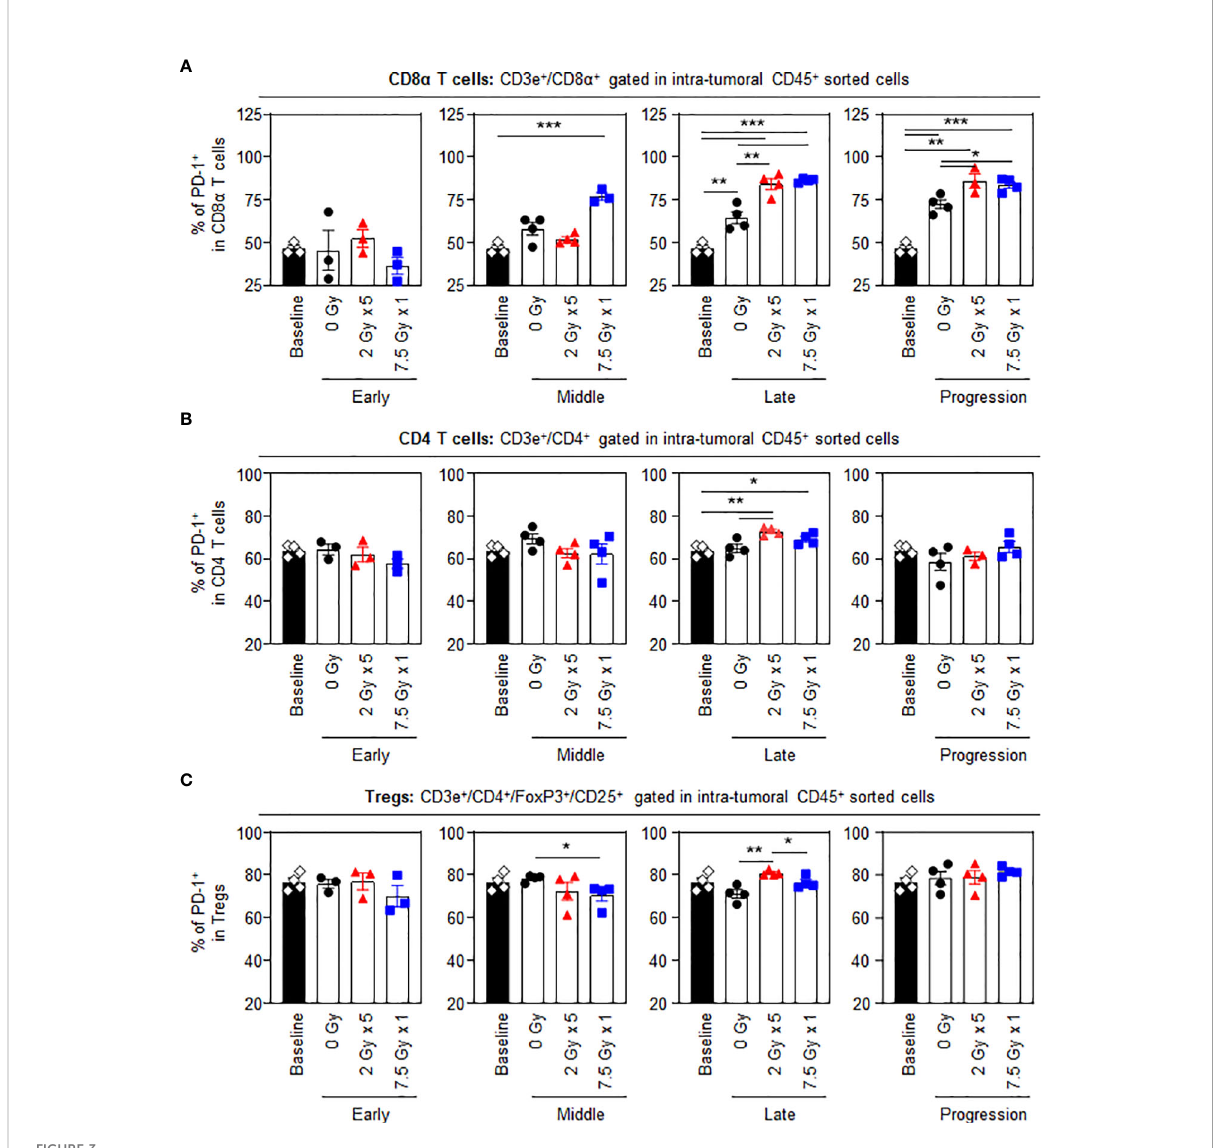
FIGURE 3 PD-1 levels in intratumoral T-cell subsets following RT. Altered proportions of intratumoral (A) PD-1 + CD8 a T, (B) PD-1 + CD4 T, and (C) PD-1 + Treg cells for each time phase. All data are presented as mean ± SEM. * P < 0.05, ** P < 0.01, and *** P < 0.001 based on unpaired two-tailed t -test. Results of one-way ANOVA analyses for each time phase are listed in Table S4. These fi gures are based on the representative data obtained from at least two independent experiments. Abbreviations: PD-1, programmed death-1; RT, radiotherapy; Treg, regulatory T; SEM, standard error of the mean; ANOVA, analysis of